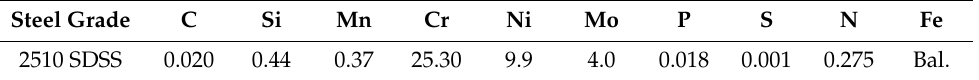
Table 1. Chemical composition of the investigated steel (wt.%).